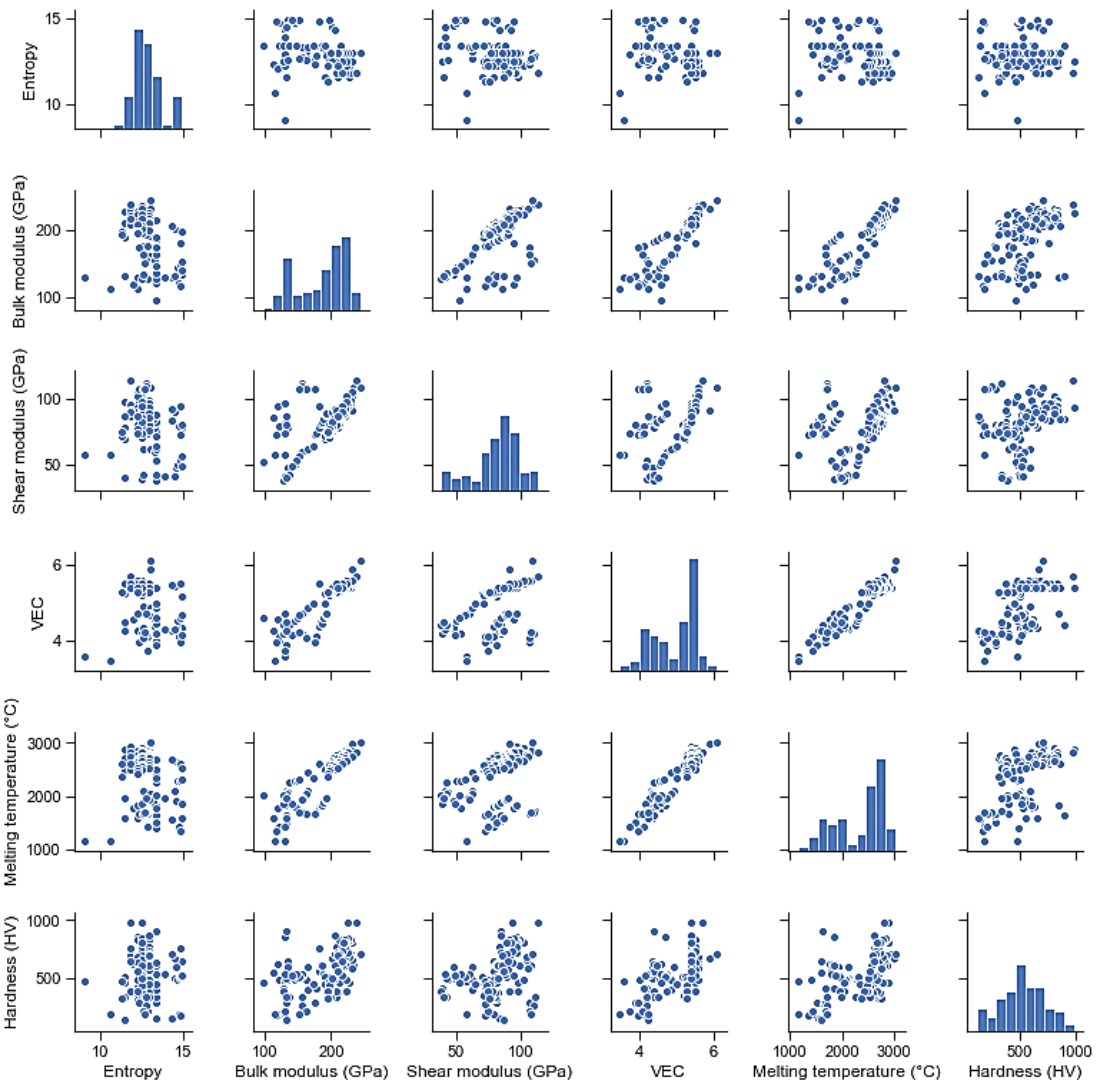
Figure 1. Scatterplot matrices of six features from the 128 samples data. Table 1. The calculated Pearson’s correlation coefficients which are related to different features of high entropy alloys (HEAs) in 128 data samples.